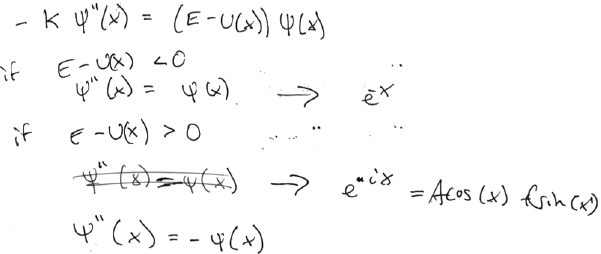
FIG. 13. Student work (written by Morgan) summarizing the possible solutions to the Schrödinger equation for constant